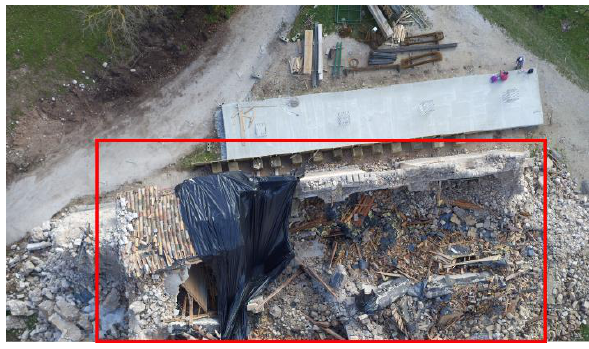
Figure 14. Image to build the orthophoto. The red rectangle frames the portion depicted in the orthophoto. As expected, the orthophoto of San Salvatore Church results more complete than the Civic Tower one, thanks to lower height gradient, which does not produce obstructions.